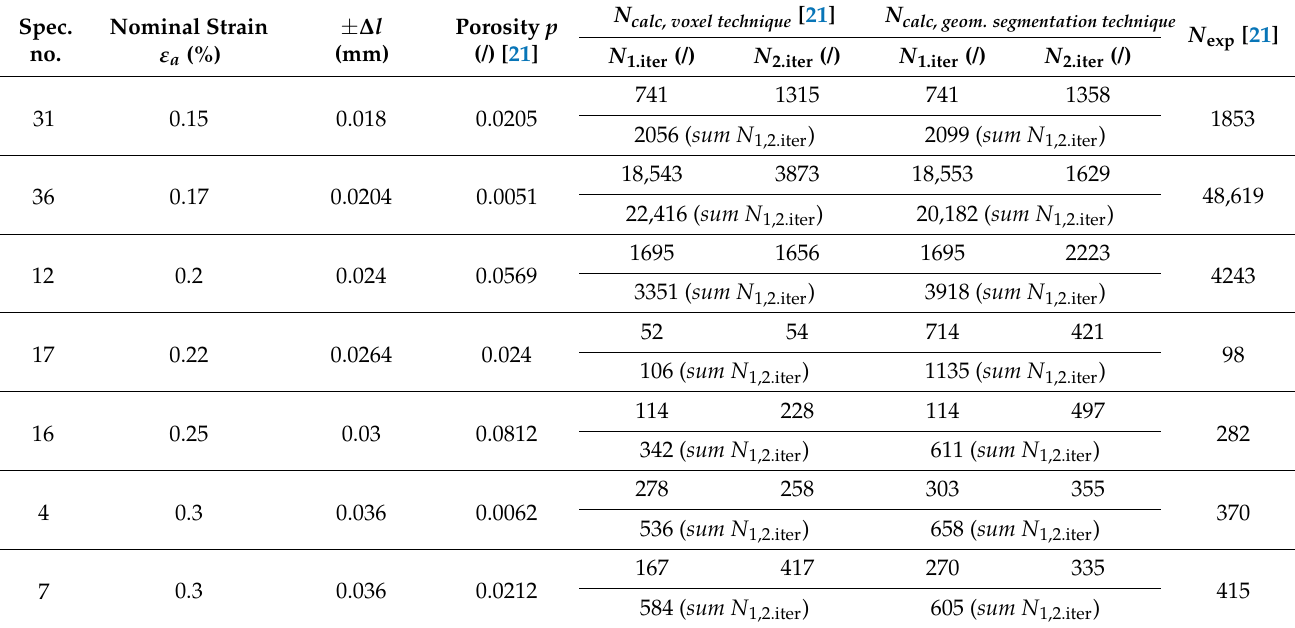
Table 4. Experimentally determined and numerically estimated fatigue lives for AlSi9Cu3 porous specimens. Spec.